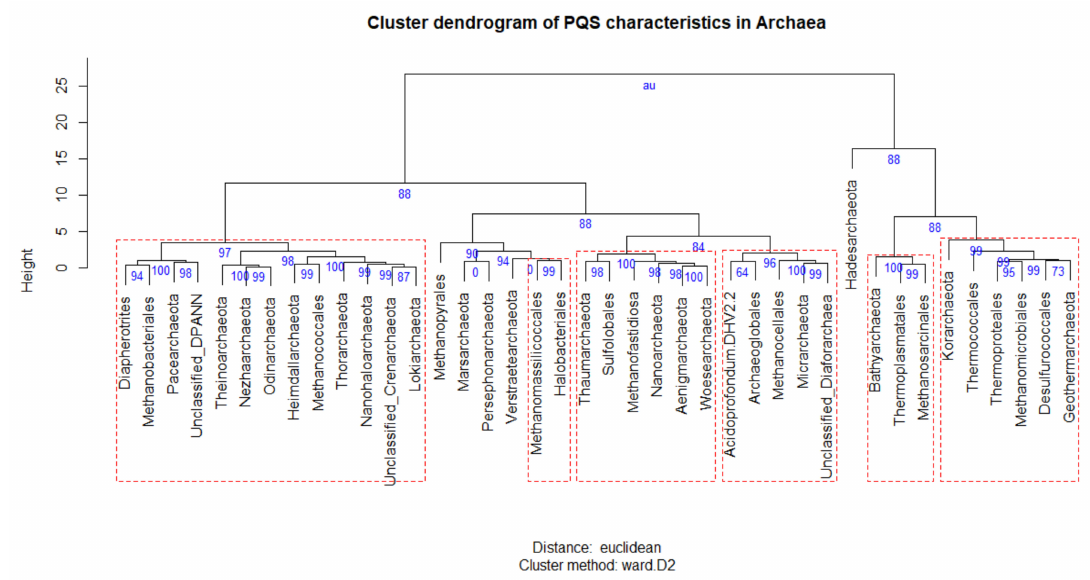
Figure 5. Cluster dendrogram of PQS characteristics of archaeal subgroups. Cluster dendrogram of PQS characteristics (Supplementary Table S4) was made in R v. 3.6.3 (code provided in Supplementary Table S4) using pvclust package with these parameters: Cluster method ‘ward.D2 (cid:48) , distance ‘euclidean’, number of bootstrap resamplings was 10,000. AU values are in blue and indicate the statistical significance of particular branching (values above 95 are equivalent to p -values lesser than 0.05). Statistically significant clusters are highlighted by red dashed